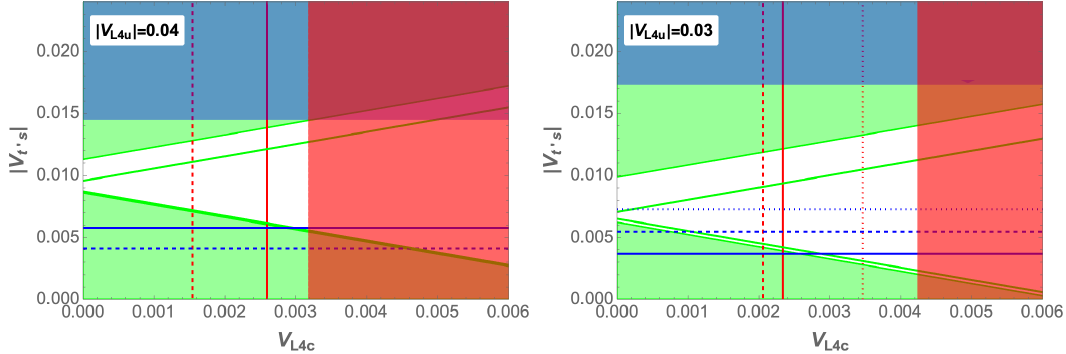
Figure 16 . Constraints on | V t 0 s | and | V L 4 c | . On the left, | V t 0 d | ≈ | V L 4 u | = 0 . 04 . The red area is excluded by the constraints on | V L 4 c | from D 0 systems with M t 0 = 1 TeV, as reported in eq. (5.20). The red line shows where the boundary is shifted if the mass of the extra quark is taken as M t 0 = 2 . 5 TeV. The blue area is excluded by neutral kaons mass difference, using the result | V t 0 s | < 1 . 4 · 10 − 2 from eq. (5.23). The blue line indicates where the forbidden region expands if the mass of the extra quark is taken as M t 0 = 2 . 5 TeV. The green region is excluded by the relation in eq. (5.38), using the values for V t 0 b allowed by the limit from the B-mesons system in eq. (5.31), figure 15. On the right, the same constraints are shown setting | V t 0 d | ≈ | V L 4 u | = 0 . 03 as a conservative benchmark value. The red and blue continuous (dotted) lines show where the boundaries from D-mesons and K-mesons shift if the mass of the extra quark is taken as M t 0 = 5 TeV ( M t 0 = 2 . 5 TeV). The dashed lines in both figures indicate the boundaries of the excluded area under more stringent assumptions. In particular, ∆ K = 0 . 1 is chosen in eq. (5.22) and the new contribution to D-mesons mass difference is limited as one third of the experimental value